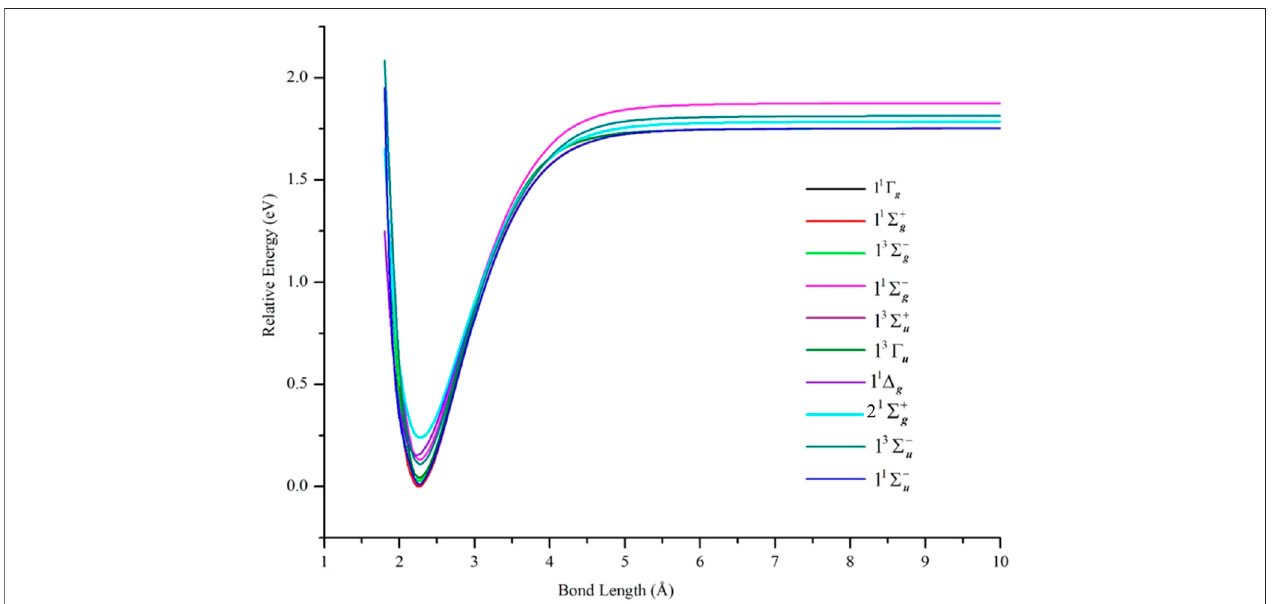
FIGURE 2 | PECs of low-lying electronic states of Ni 2 computed at the GVVPT2 level of theory using the cc-pVTZ basis set. All energies are plotted relative to the lowest energy value of the ground X 1 Γ g term. For all states, the holes are in the 3d delta orbitals ( δδ – holes) except for 1 1 Δ g and 2 1 Σ g+ states which are ππ – hole states.